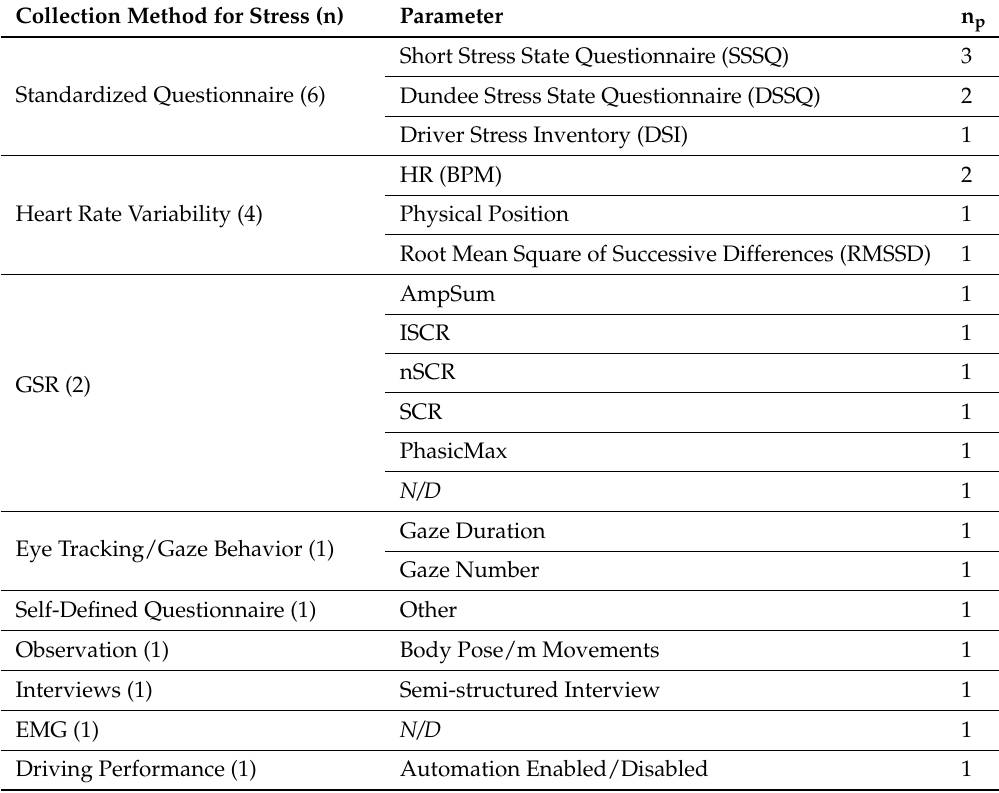
Table 8. Stress collection methods and